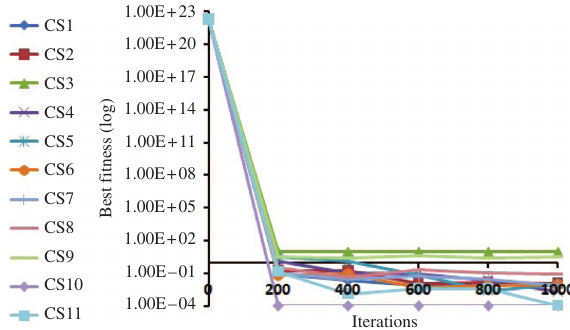
Figure 3: Convergence Trend of f 1 .